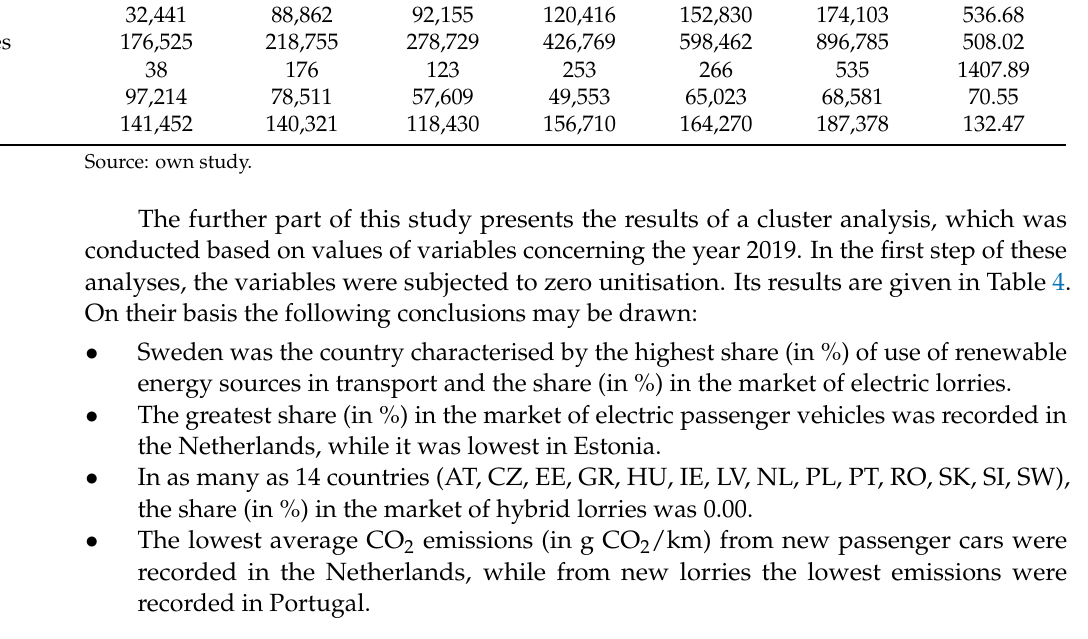
Table 4. Normalised values of variables included in this